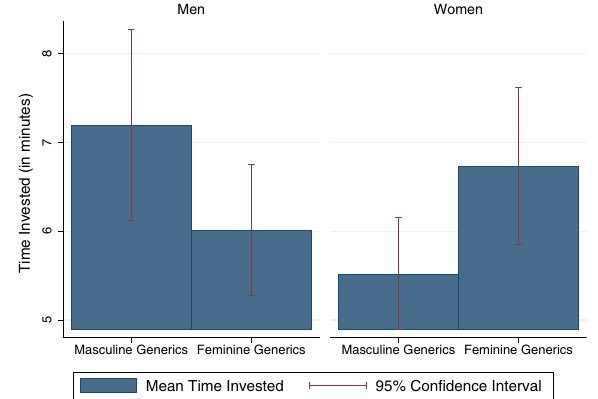
Fig. 3 Mean time invested in the maths test, by gendered address. Female participants spent more time on their maths exam when addressed in the feminine, compared to the masculine. Male participants spent less time on their maths exam when addressed in the feminine, compared to the